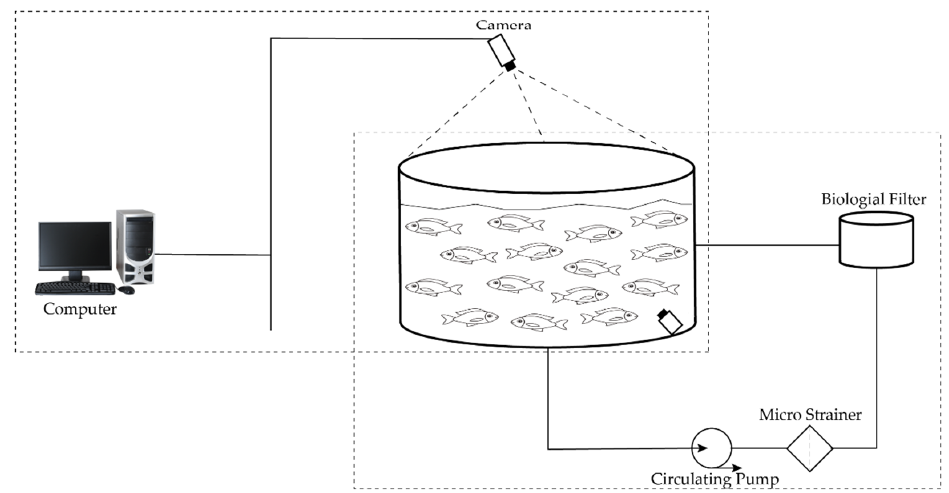
Figure 2. Fish data acquisition experimental setup.